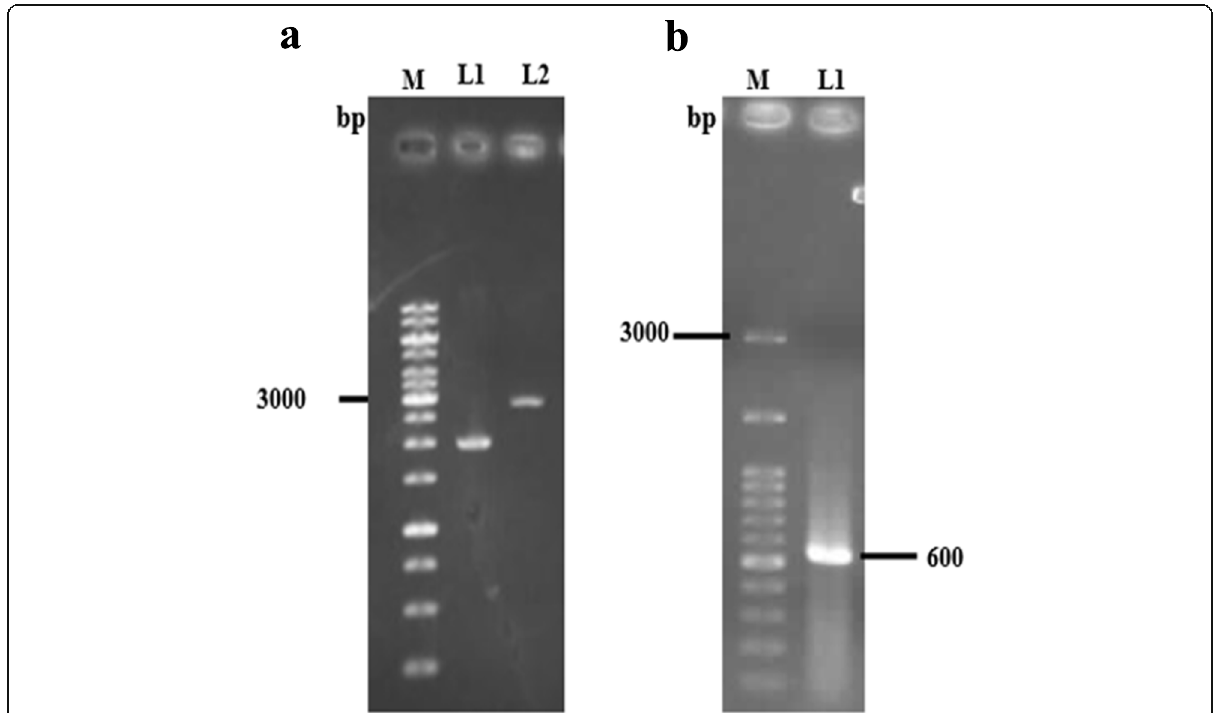
Fig. 4 Assessment of adaptor performance using pTZ57R plasmid. a M, DNA ladder; L1, intact supercoil plasmid; L2, digested plasmid with EcoR I. b M, DNA ladder; L1, amplified 600-bp PCR product of AP1 (forward) and Hr (reverse)